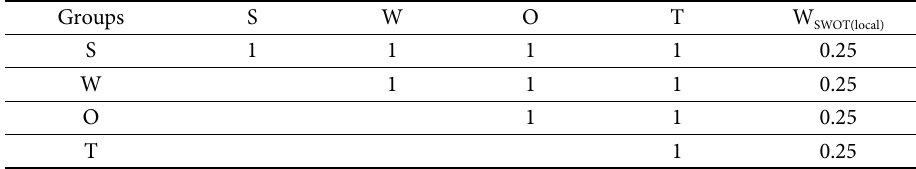
Table 3. Pair-wise comparison matrix and weights of SWOT factors